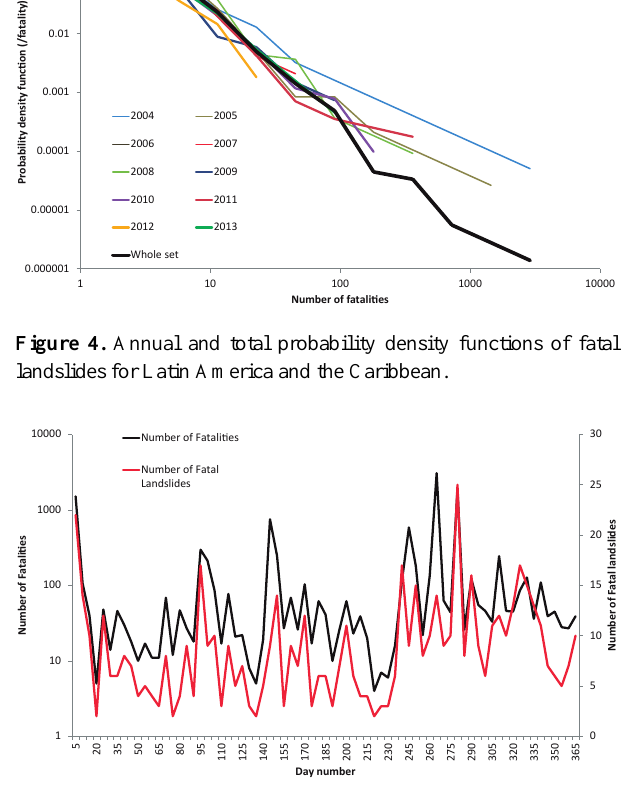
Figure 5. Annual cycle of fatal landslides and fatalities shown in 5-day bins